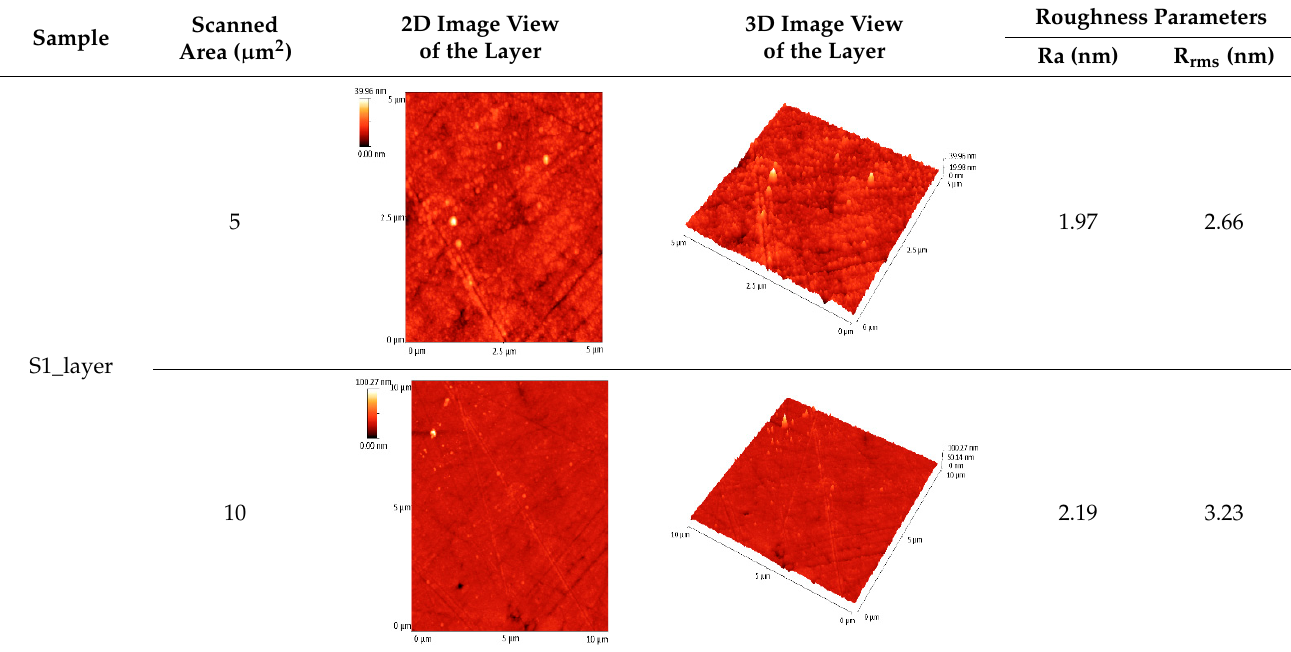
Figure 8. XRD analyses of sintered samples and coated using e-gun technology. ( a ) XRD spectra of thin film deposition on the glass substrate in case of samples S1, S3 and S5; ( b ) XRD spectra of thin film deposition on two glass samples in similar conditions like in the case of samples S1 and S3. Table 1. Surface morphology and roughness realized by AFM analyses.